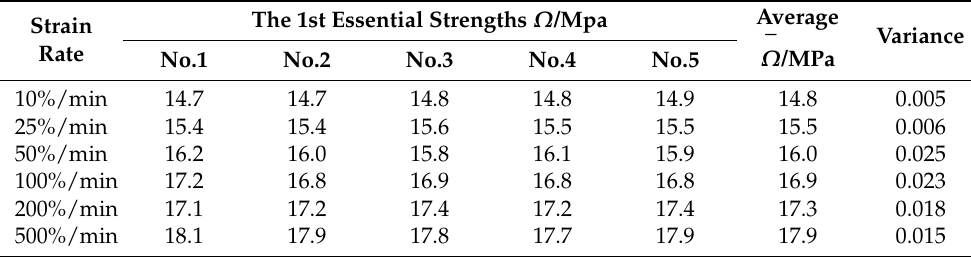
Table 2. The 2nd essential strength values ( 𝛺′ ) of ETFE membrane material under different strain rates. The 2nd Essential Strength 𝛺′ /MPa Strain Rate